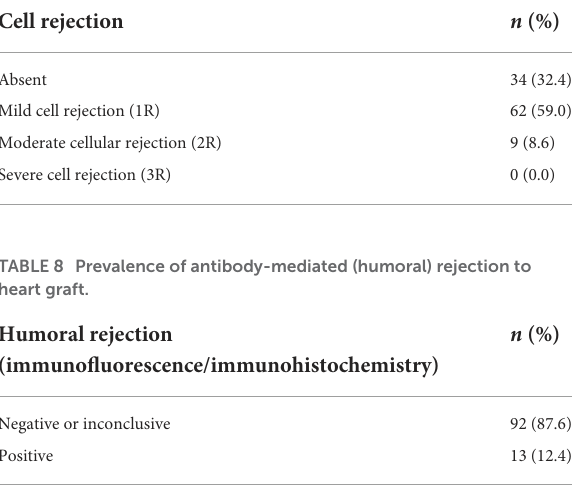
TABLE 7 Prevalence of cellular rejection to heart graft.